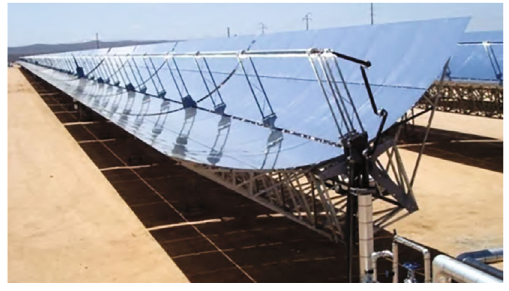
Figure 1: Linear parabolic power plant